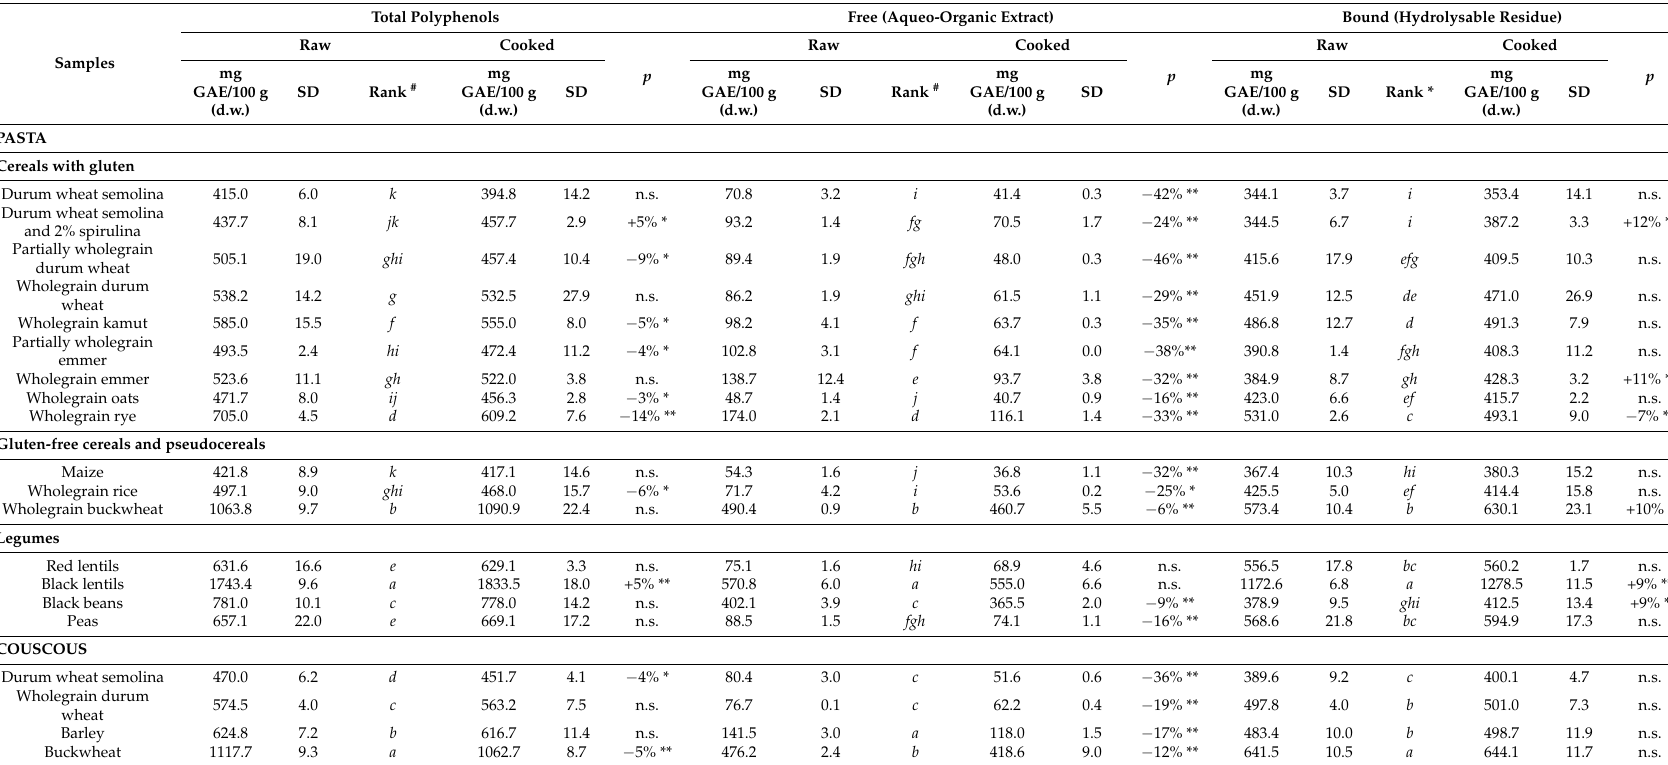
GAE, Gallic Acid Equivalent; d.w., dry weight; SD, standard deviation; p , percent difference between values of raw and cooked samples and level of statistical significance: * p < 0.05; ** significant, p < 0.01; n.s., not significant. # Equal letters correspond to a difference below the least significant difference after one-way Analysis Of Variance (ANOVA). ANOVA was performed separately on the pasta and the couscous sample